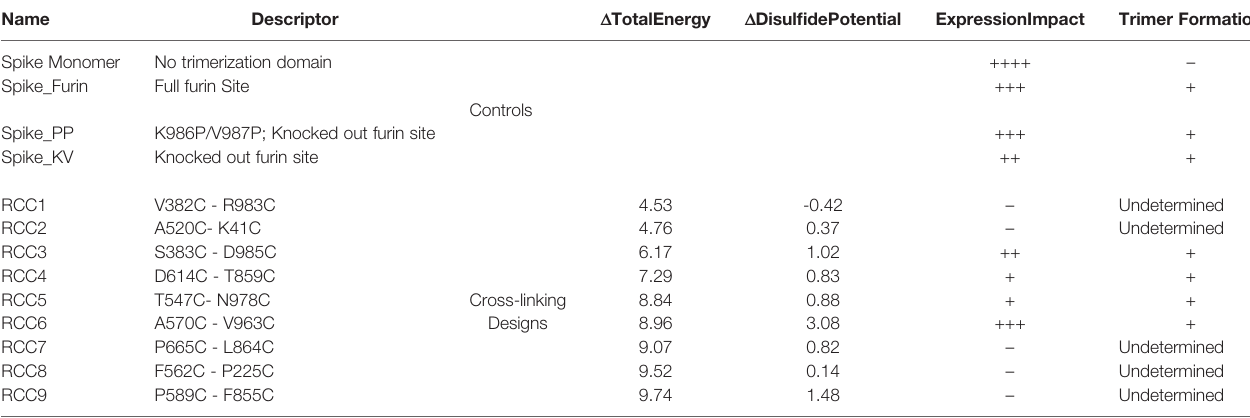
Table includes the shorthand name of different Spike elements explored here, the descriptor of each design, Talaris 2014 energies, the dslf_fal3 energy term, relative expression impact (denoted as -,+ > 0 µg/L, ++ > 100 µg/L, +++ > 500 µg/L, or ++++ > lOOOµg/L), and trimer fmmation (denoted as +, -, or